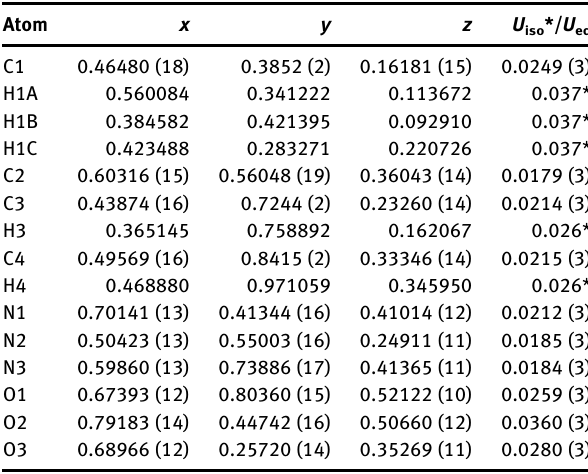
Table  : Fractional atomic coordinates and isotropic or equivalent isotropic displacement parameters (Å 